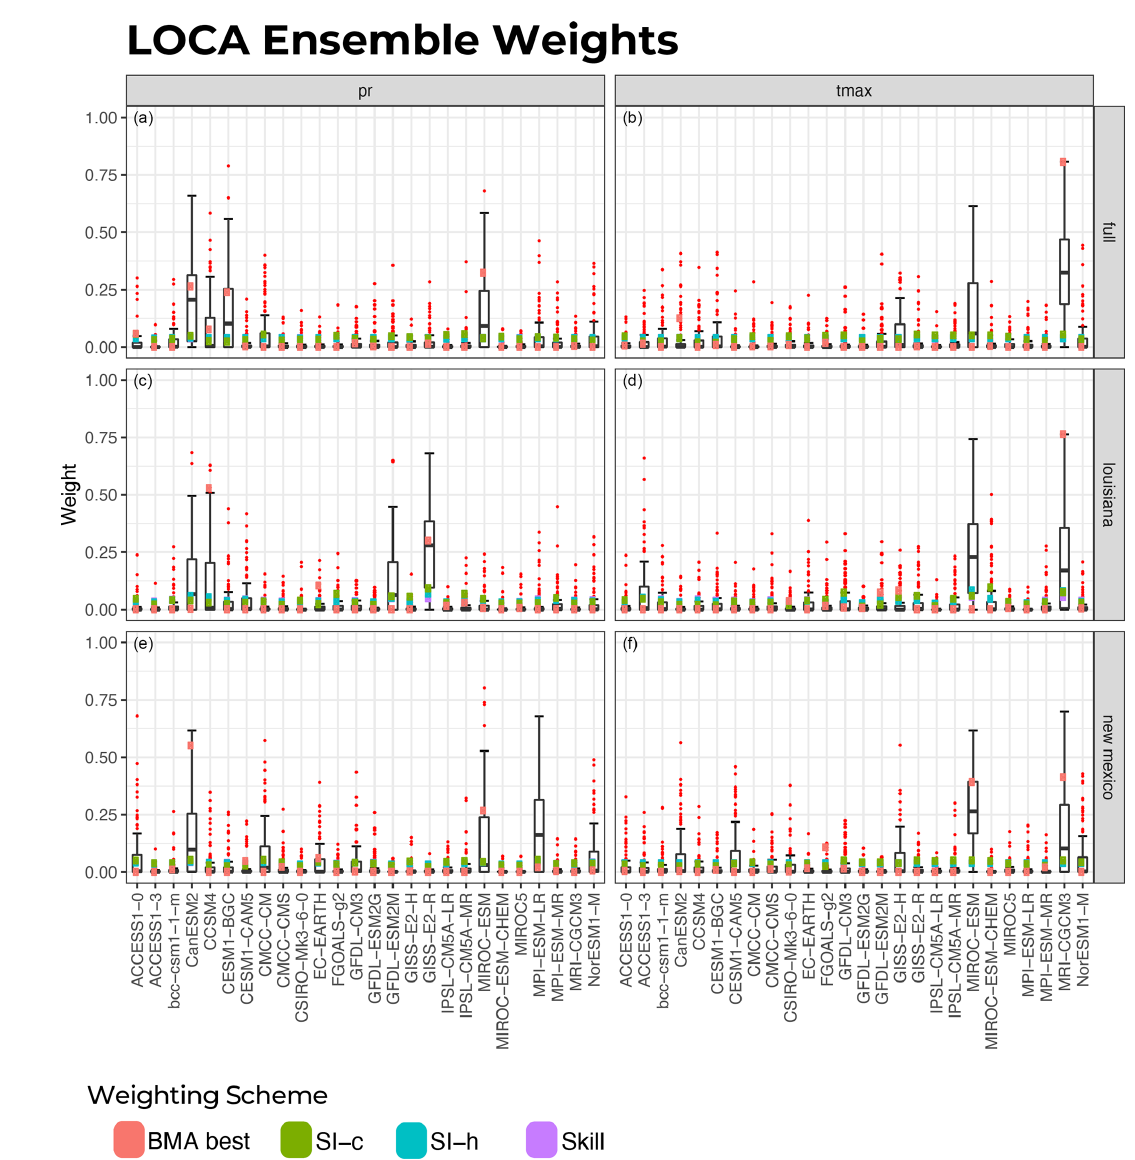
Figure 4. Same a Fig. 3, but for the LOCA